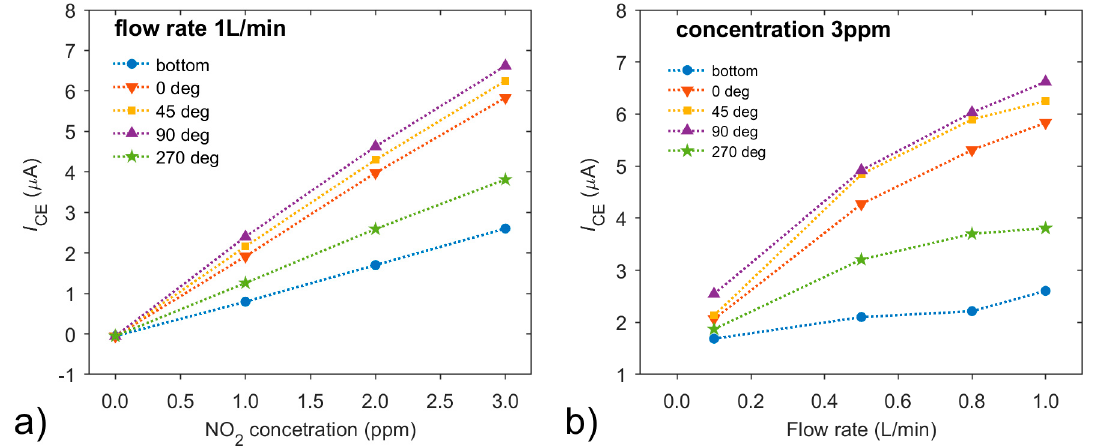
Figure 13. Dependences of direct current (DC) ( a ) on NO 2 concentration at the constant flow rate of 1 L/min; or ( b ) on the flow rate at the constant concentration of 3 ppm, with sensor orientations of 0°, 45°, 90° and 270°. Conditions: 298 K, 40 %RH.